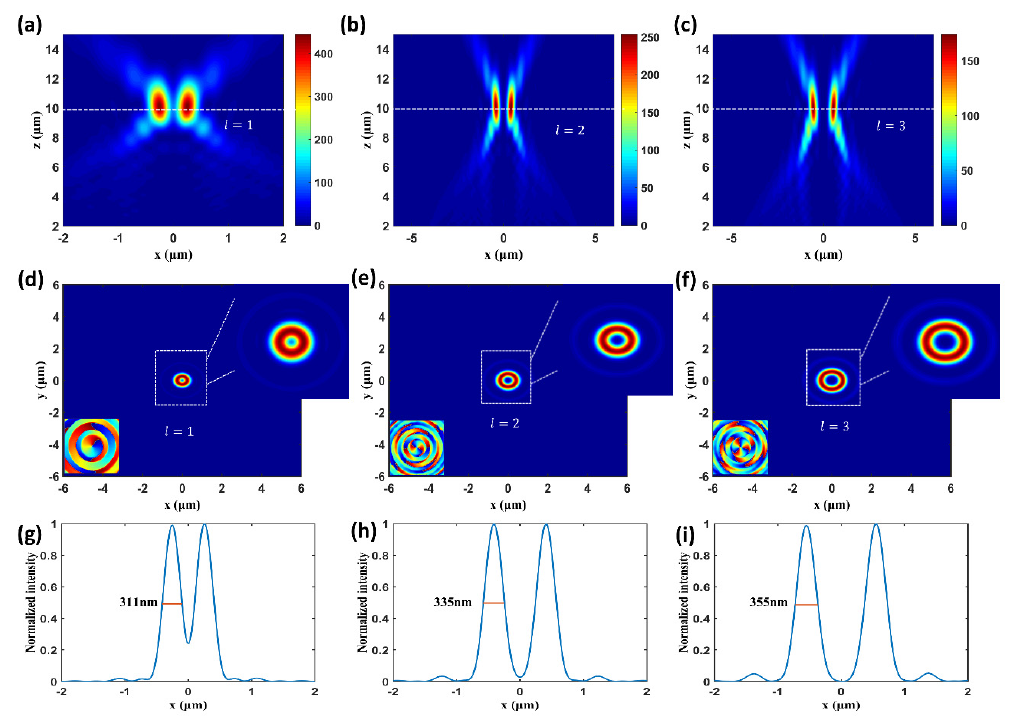
Figure 4. Numerically simulated results for a focused optical vortex (FOV) generator. Electric field intensity profile in xz -plane for ( a ) l = 1, ( b ) l = 2, and ( c ) l = 3. The white dashed line denotes the focal plane. The vortex rings are imaged at the focal plane, z = 10 µ m, along with their phase pattern in the corresponding bottom-left inset figure for ( d ) l = 1, ( e ) l = 2, ( f ) l = 3 in xy -plane, ( a , d ), ( b , e ), and ( c , f ) share the same color bars, respectively. The upper-right inset maps show the amplification of the vortex ring. ( g – i ) The corresponding horizontal cuts of vortex rings at the focal spot having a full width half maximum (FWHM) of 311 nm, 335 nm, and 355 nm, respectively.